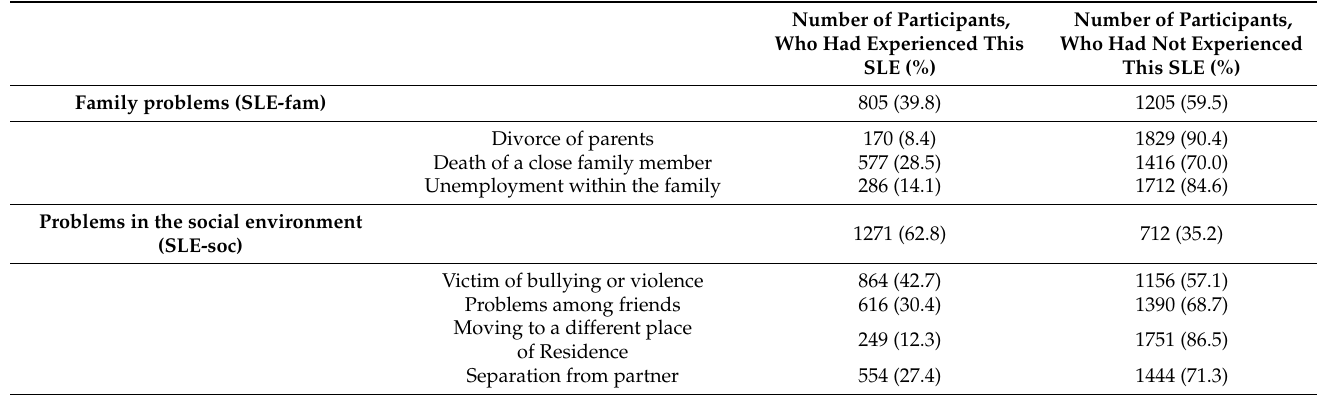
Table 1. Frequency of experienced SLE ( n =